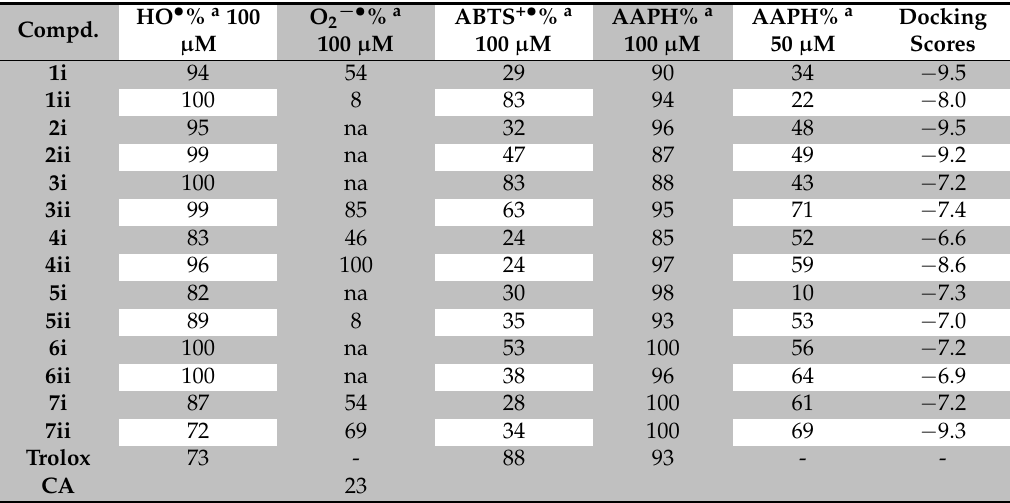
Table 2. In vitro % radical scavenging activity, hydroxyl (HO • %) and superoxide (O 2 −• %) radicals, % Decolorization activity ABTS + • %, % anti-lipid peroxidation (AAPH) assays, docking scores.